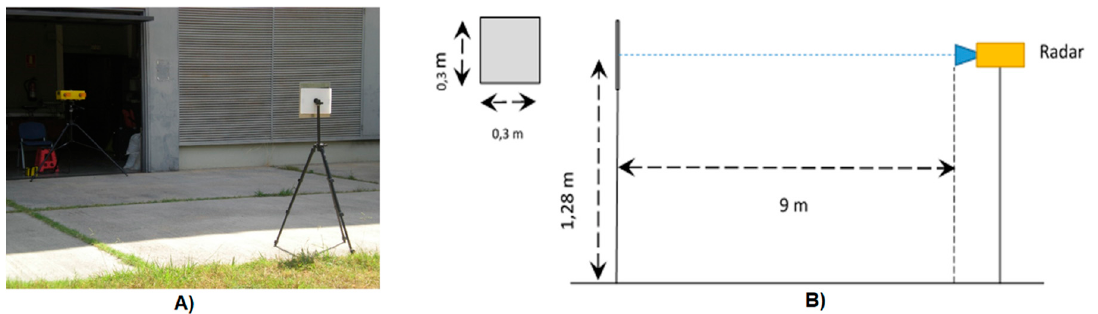
Figure 6. ( A ) Picture of the experiment setup. ( B ) Scheme of the measurements carried out to estimate the gain of the system when measuring through CP patch arrays a single target (i.e., a metal square 30 cm × 30 cm).